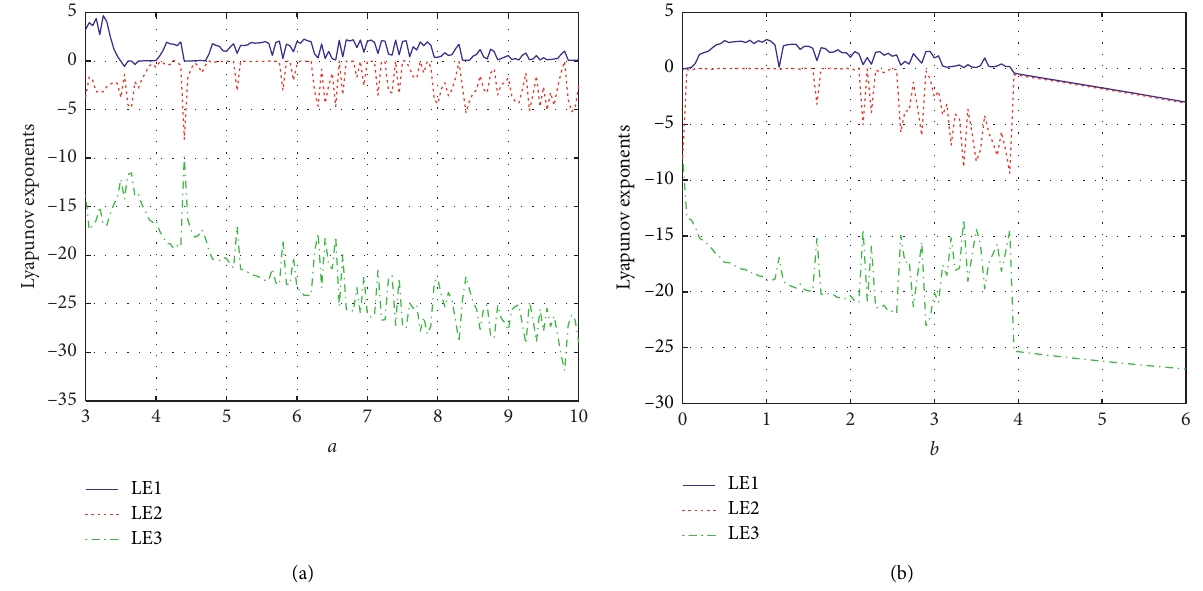
Figure 10: Lyapunov exponents spectrum of fractional order with a and b varying. (a) a varying. (b) b